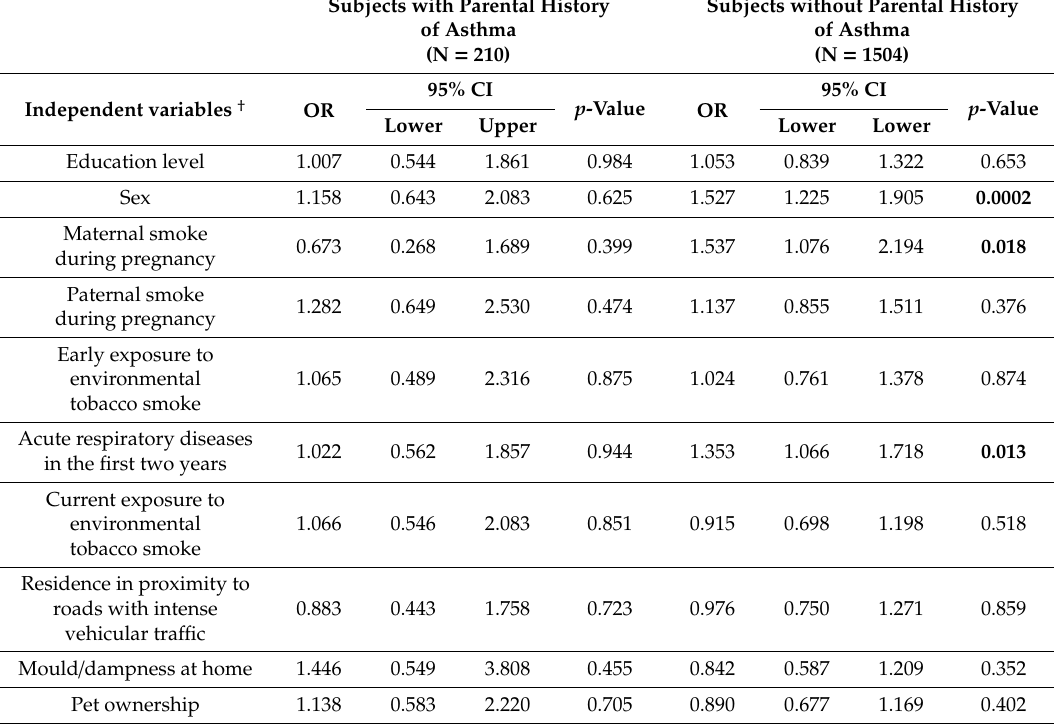
Table 5. Multiple logistic association model for allergic sensitization, separately for subjects with and without parental history of asthma. OR: Odds Ratio; 95% CI: 95% confidence interval. Significant p -Values are in